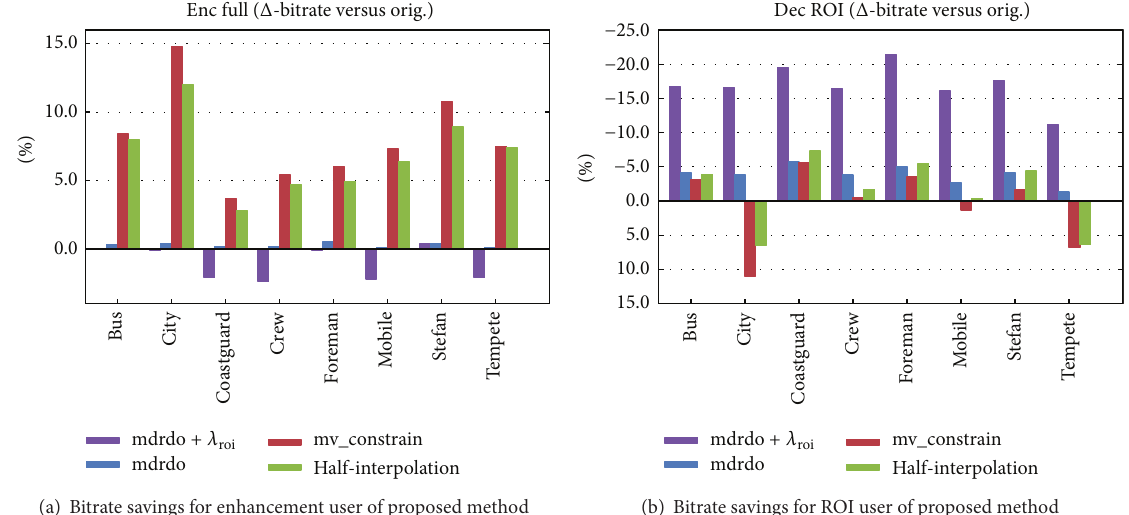
Figure 11: RD performance for quality SVC with proposed RDO framework.